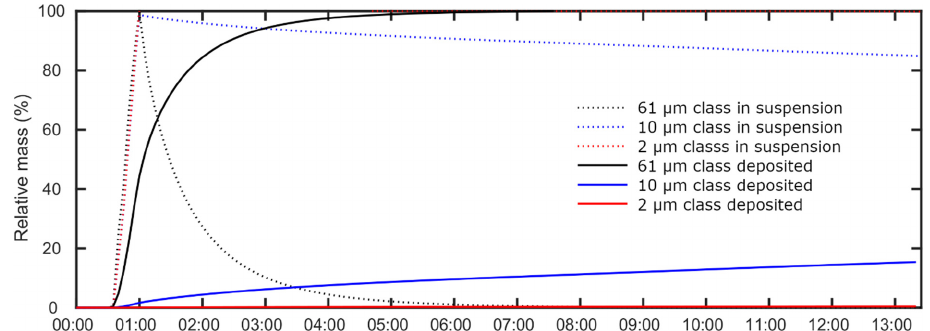
Figure 8. Percentage of deposition (solid line) and in suspension (dashed line) for each class: 61 µm class (settling velocity of 1.67 mm/s), 10 µm class (settling velocity of 0.05 mm/s), 2 µm class (settling velocity of 0.001 mm/s).